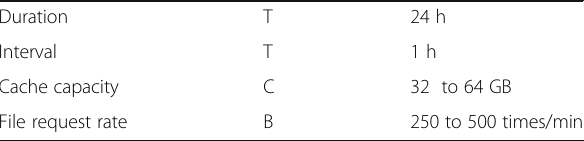
Table 2 Simulation parameter